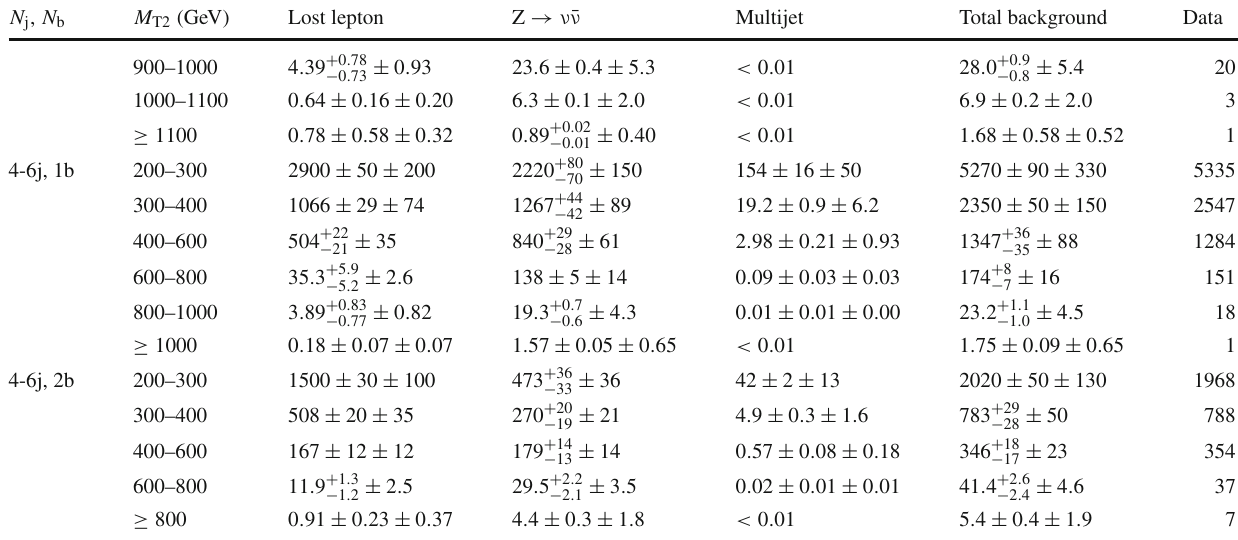
the limited size of data control samples and Monte Carlo samples), and the second is systematic